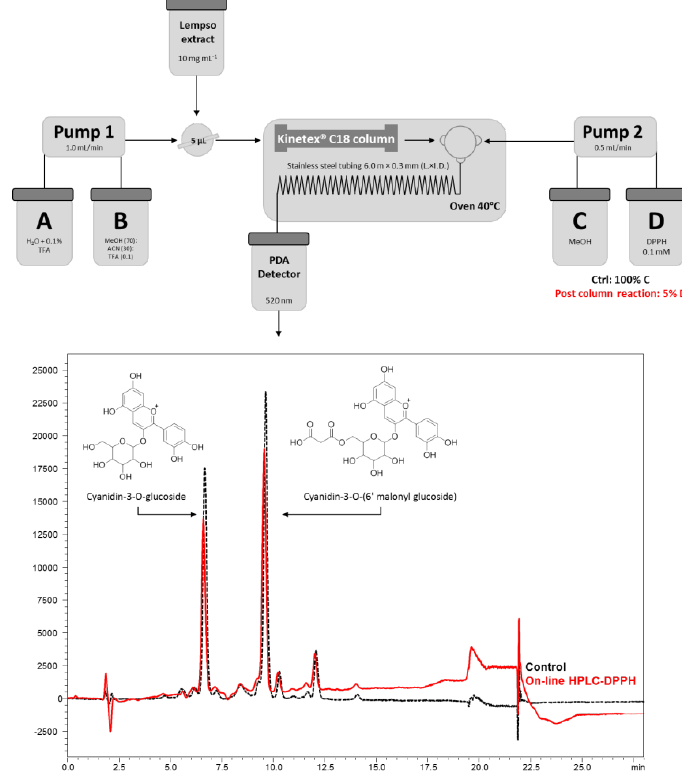
Figure 1. On-line High Performance Liquid Chromatography-Photodiode Array-2,2′ -Diphenyl-1-picrylhydrazyl (HPLC-PDA-DPPH) profiles of anthocyanins in Lempso extract. Black and red lines denote the control and post column reaction, respectively.